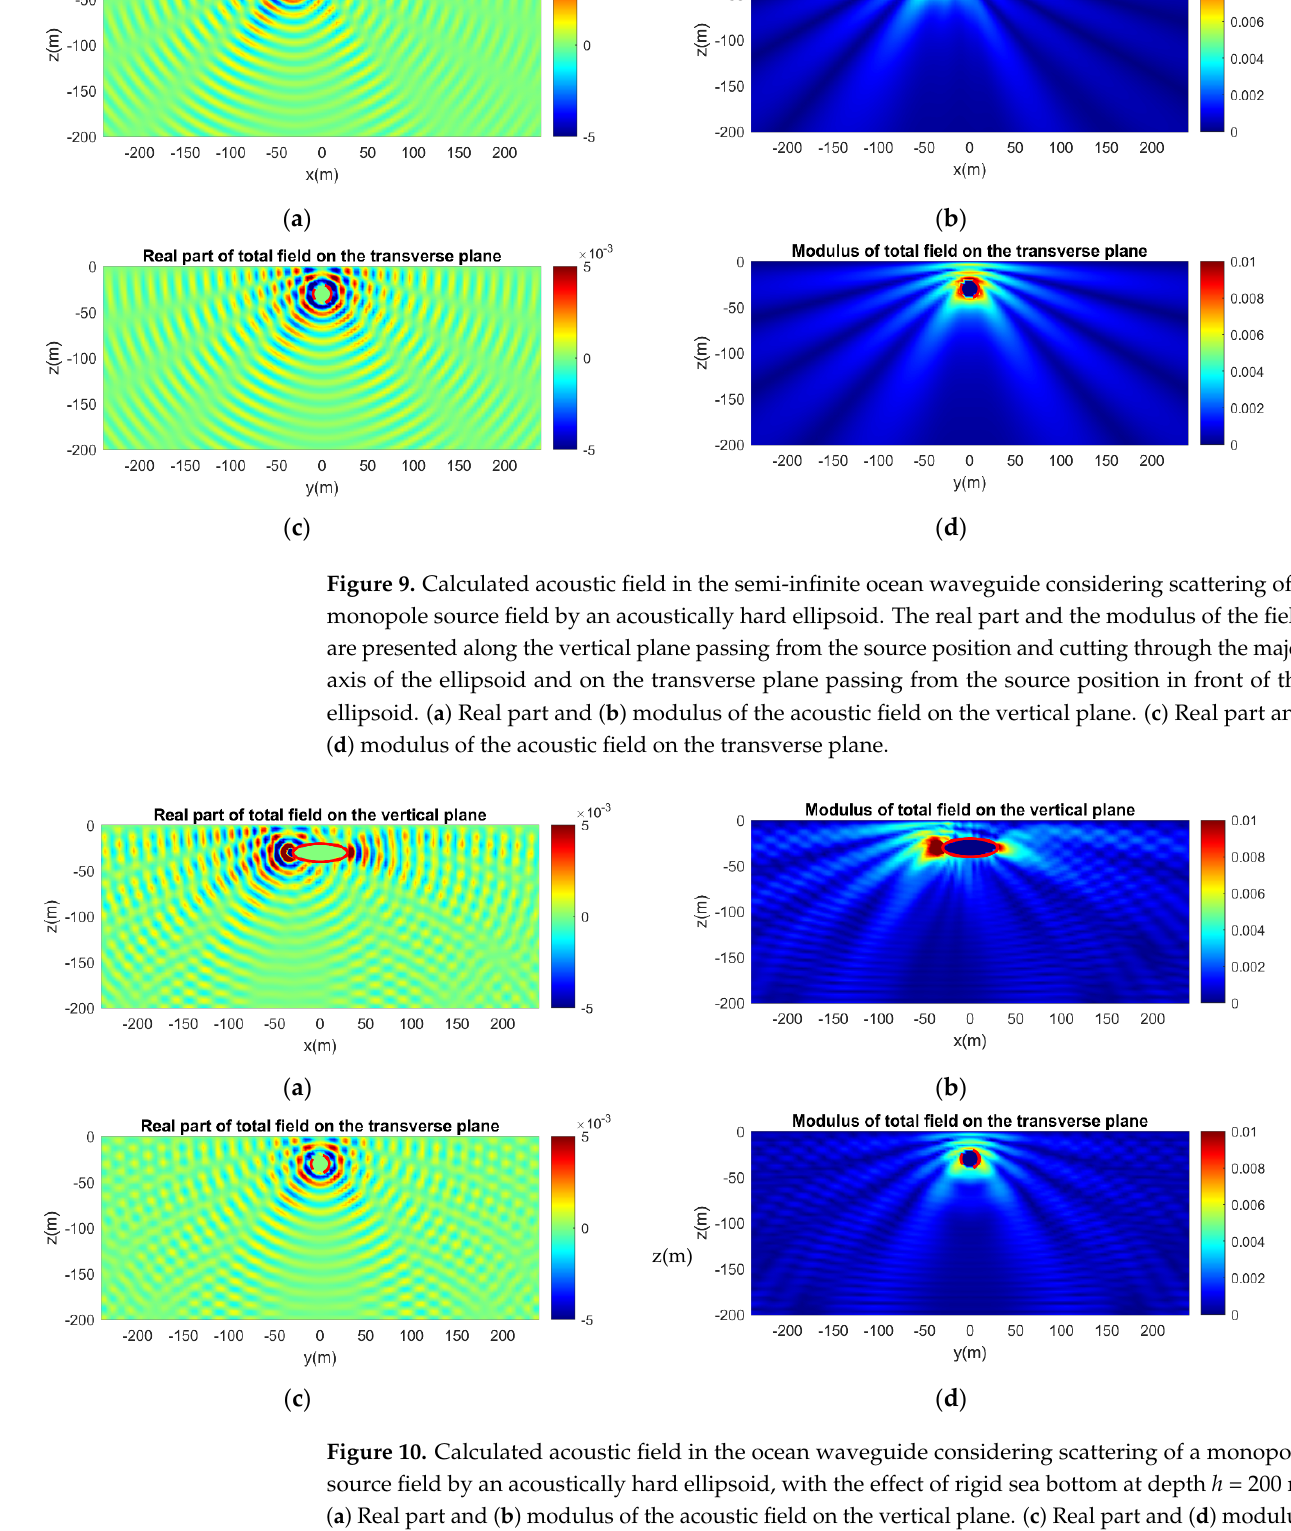
( d ) Figure 11. Same as Figure 10, but for a horizontal dipole source. The axis of the dipole is parallel to the major axis of the ellipsoid (x-axis). ( a ) Real part and ( b ) modulus of the acoustic field on the vertical plane. ( c ) Real part and ( d ) modulus of the acoustic field on the transverse plane.